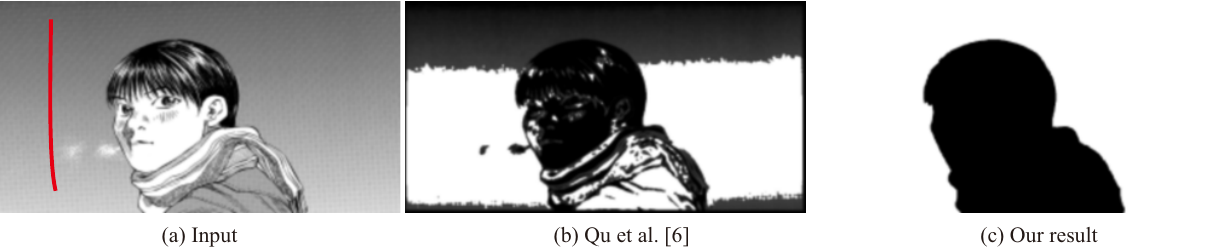
Fig. 10 ‘Boy’ (1712 × 907, loading time: 9.72s, processing time: 2.07s).